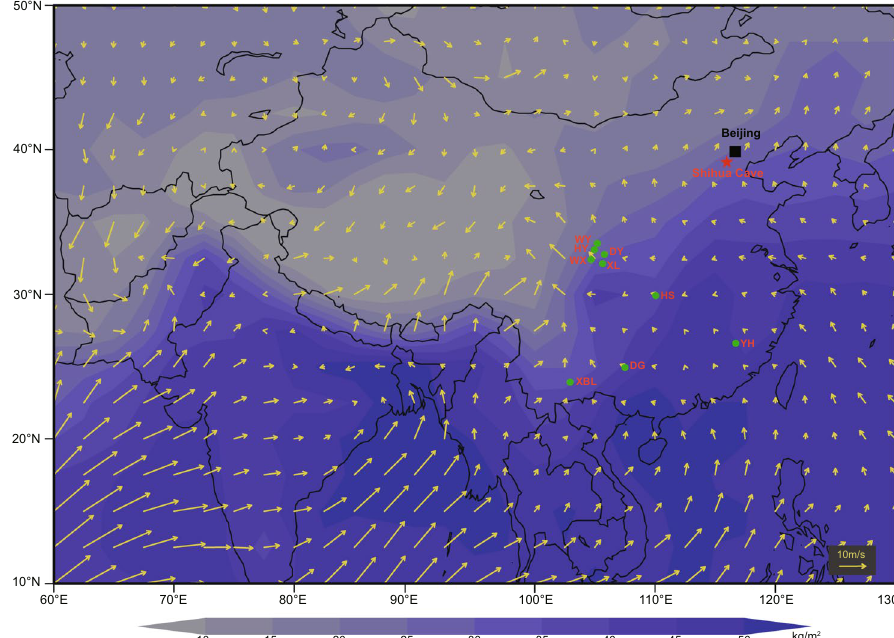
Figure 1. Precipitable water content with surface wind field and locations of Shihua and other caves. Rainy season (June–September) precipitable water content (kg/m 2 ) for the entire atmospheric column with surface wind field averaged during 1987–2016 AD based on the NCEP/NCAR reanalysis datasets 34 . The shading shows absolute value of precipitable water content and the arrows indicate the surface wind field. The location of Shihua Cave is represented by red star (this study), and the others by green circles: WY (Wuya Cave) 25 , HY (Huangye Cave) 28 , WX (Wanxiang Cave) 29 , DY (Dayu Cave) 26 , XL (Xianglong Cave) 32 , HS (Heshang Cave) 35 , YH (Yuhua Cave) 36 , DG (Dongge Cave) 37 , XBL (Xiaobailong Cave) 27 . The map is created using Open